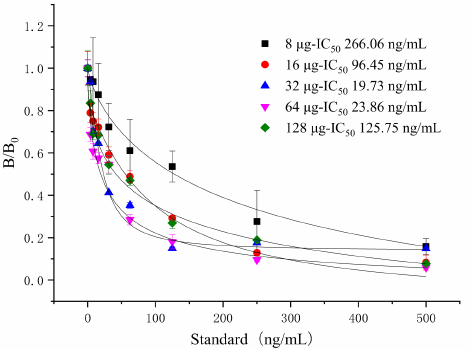
Figure 2. Selecting the amount of MAb for tylosin detection ( n =